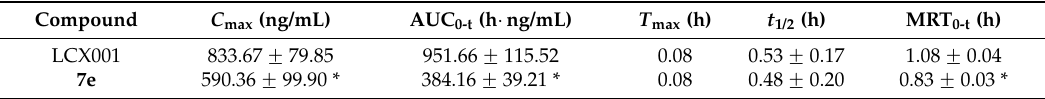
Figure 4. Concentration curve of LCX001 in plasma versus time after administration of LCX001 and prodrug 7e . Error bars show the value of SD ( n = 3). Table 2. Pharmacokinetic parameters of LCX001 in plasma after administration of LCX001 and prodrug 7e ( n =